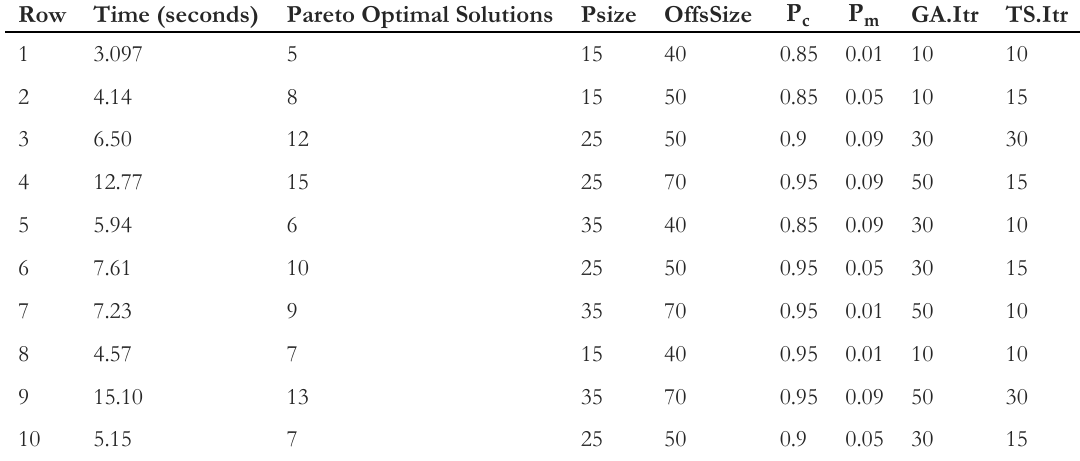
Table 9. The effect of parameter values on algorithm efficiency measures